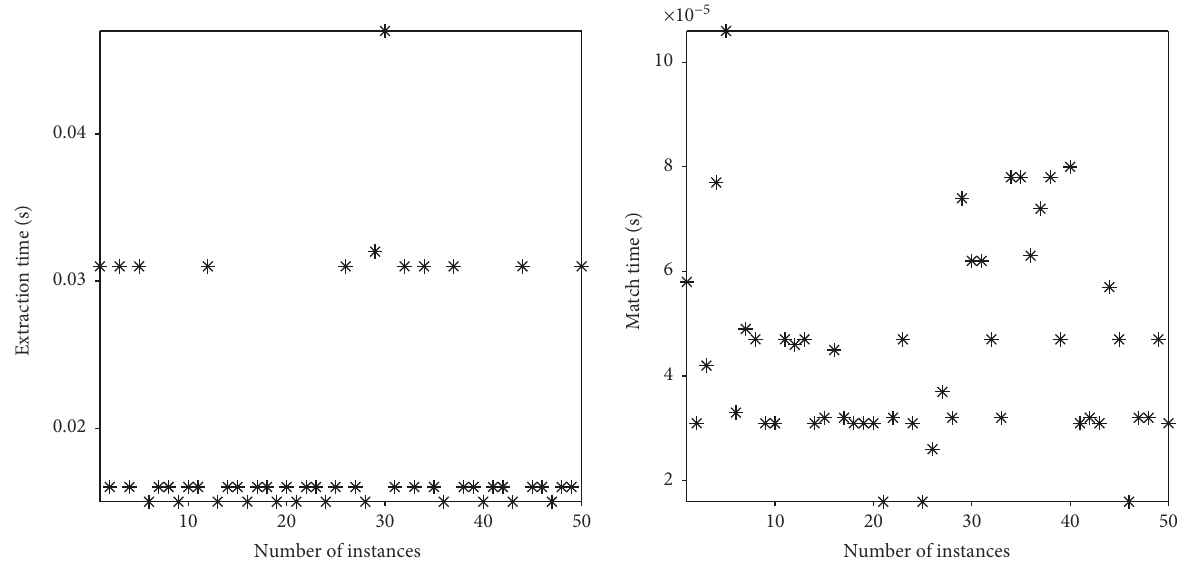
Figure 15: Time consumption for CSA-SURF.